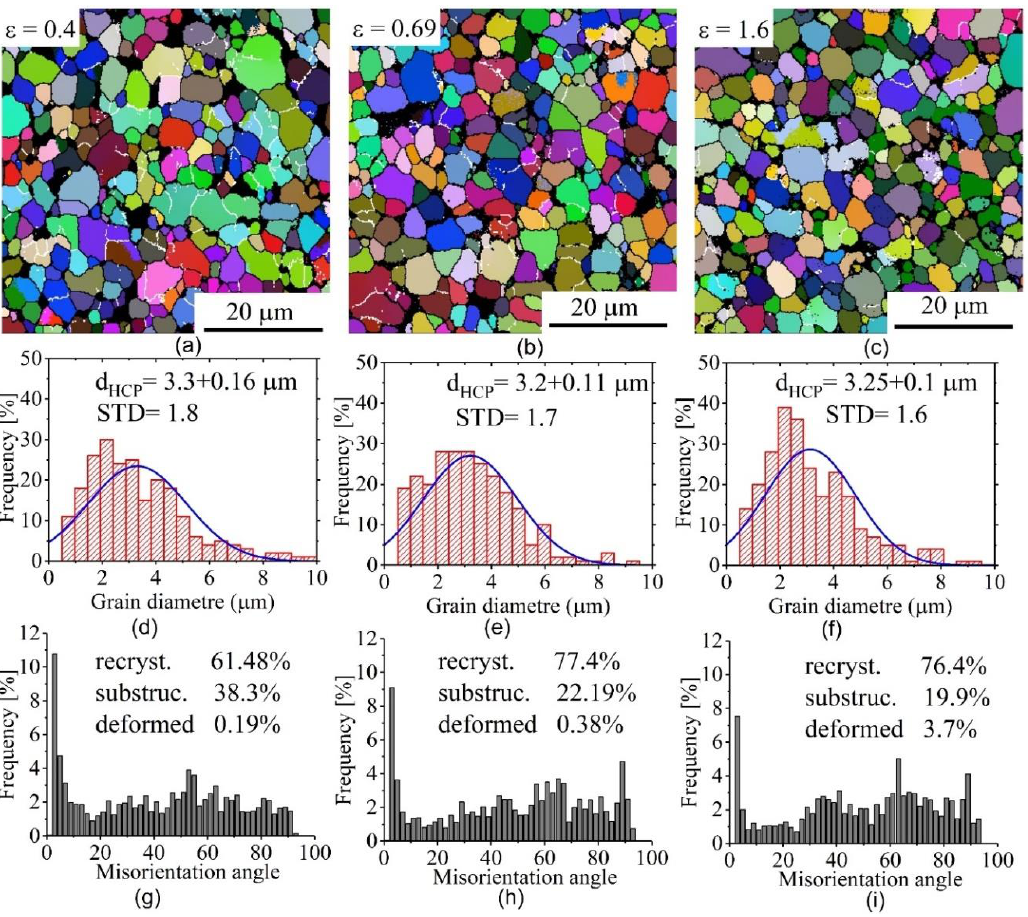
Figure 5. Electron backscattered diffraction (EBSD) grain-subgrain boundaries maps ( a – c ), grain size distribution ( d – f ) and the misorientation angle ( g – i ) at 1 × 10 -3 s -1 and 825 °C for the HCP phase.